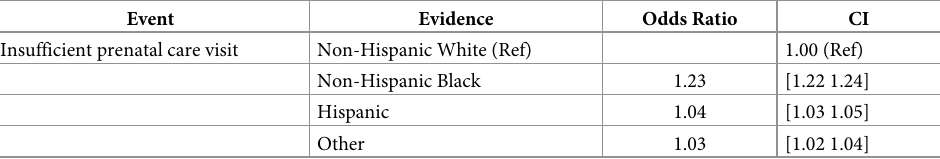
Table 5. Disparities in prenatal care